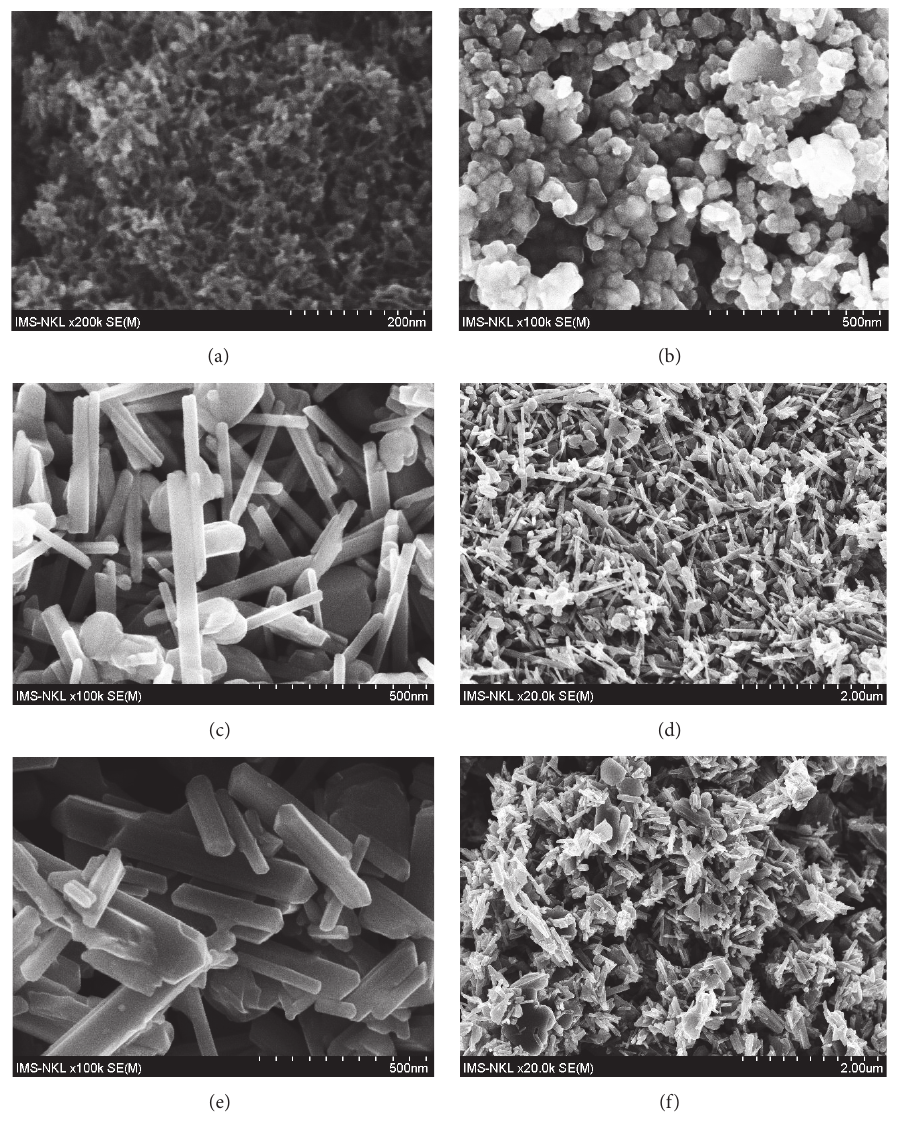
Figure 4: SEM images of material at 100 ∘ C (a), 400 ∘ (b), 600 ∘ C ((c), (d)), and 800 ∘ C ((e),